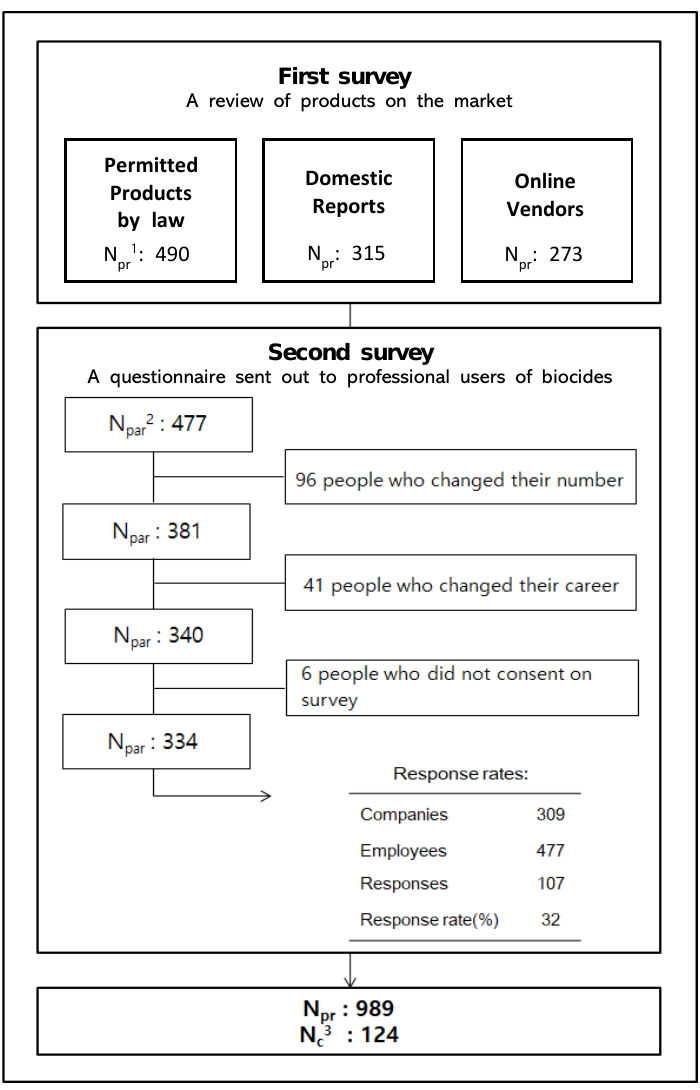
Figure 1. Flow-chart of the survey to collect information on Biocide Products and Chemicals. 1 number of products; 2 number of participants; 3 number of chemicals.